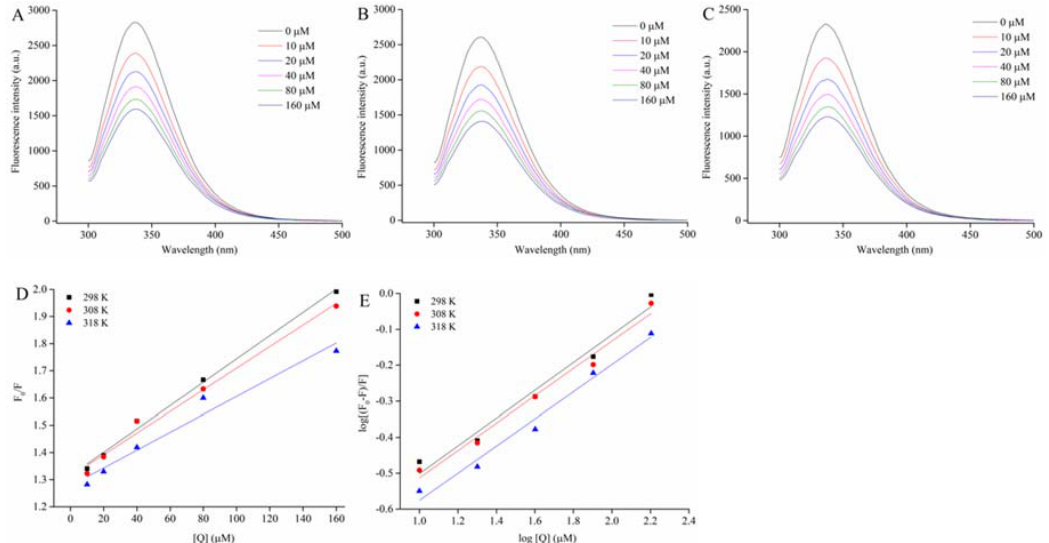
Figure 5. Effect of C3G on the intrinsic fluorescence spectrum of α‐ glucosidase at 298 ( A ), 308 ( B ), and 318 K ( C ); the Stern– Volmer plots for the quenching of α‐ glucosidase by C3G and the K q of α‐ glucosidase ‐ C3G complex in 298, 308, and 318 K, respectively ( D ); the plots for the static quenching of α‐ glucosidase by C3G ( E ).